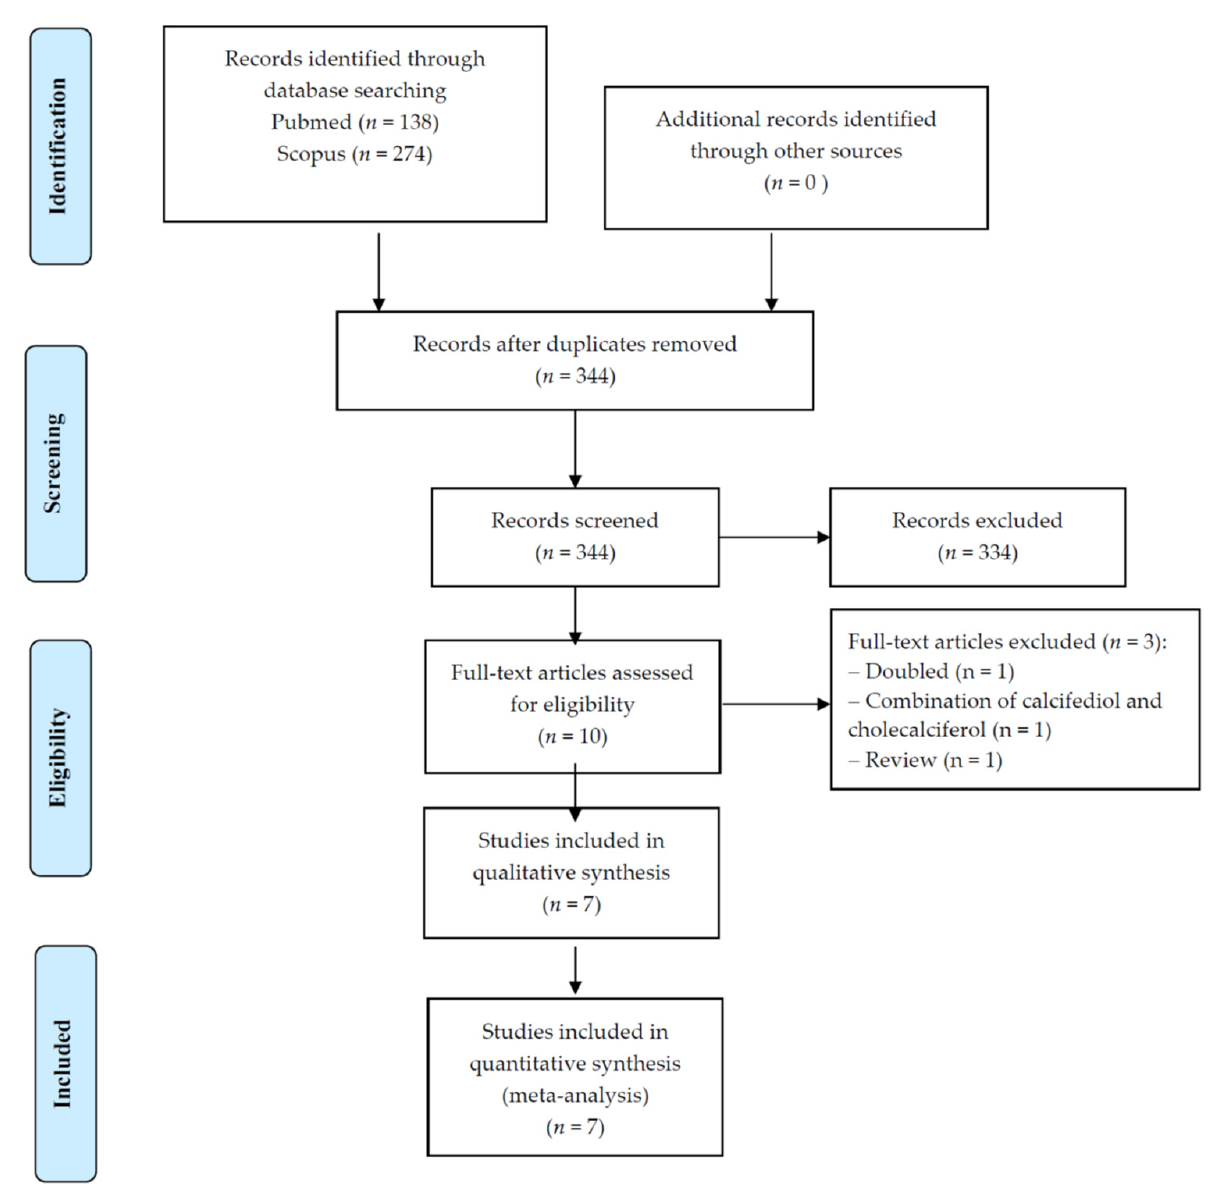
Figure 1. PRISMA Figure 1. PRISMA flow-chart.